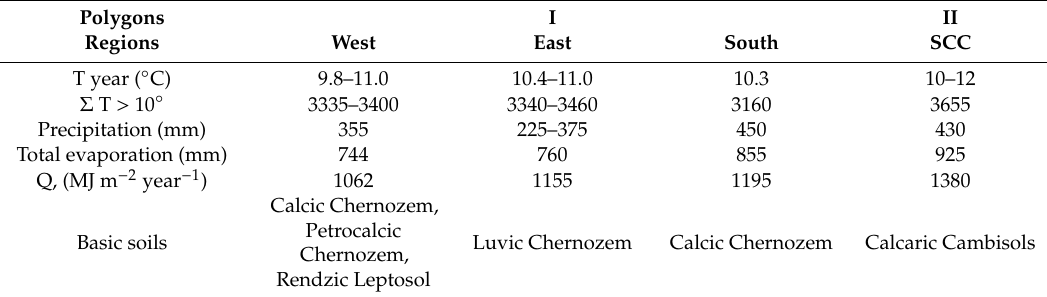
Table 2. Climate parameters [40] for polygons (I, II) and regions of